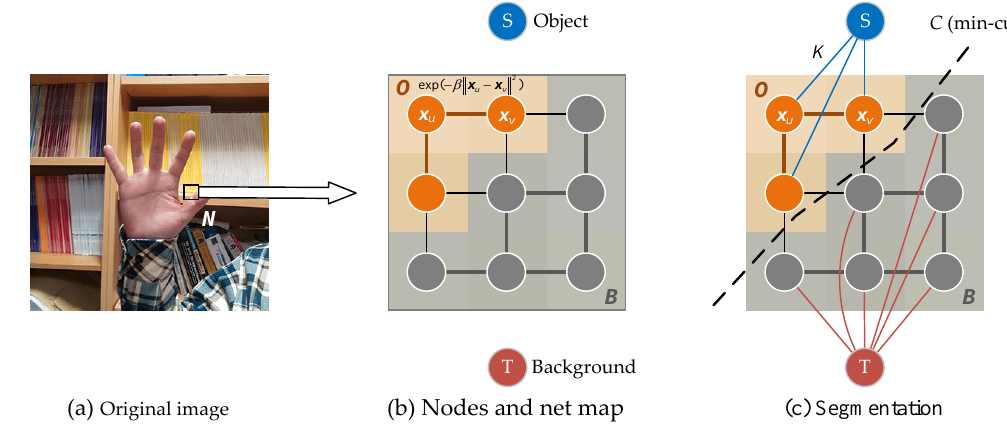
Figure 7. Nodes and net model.